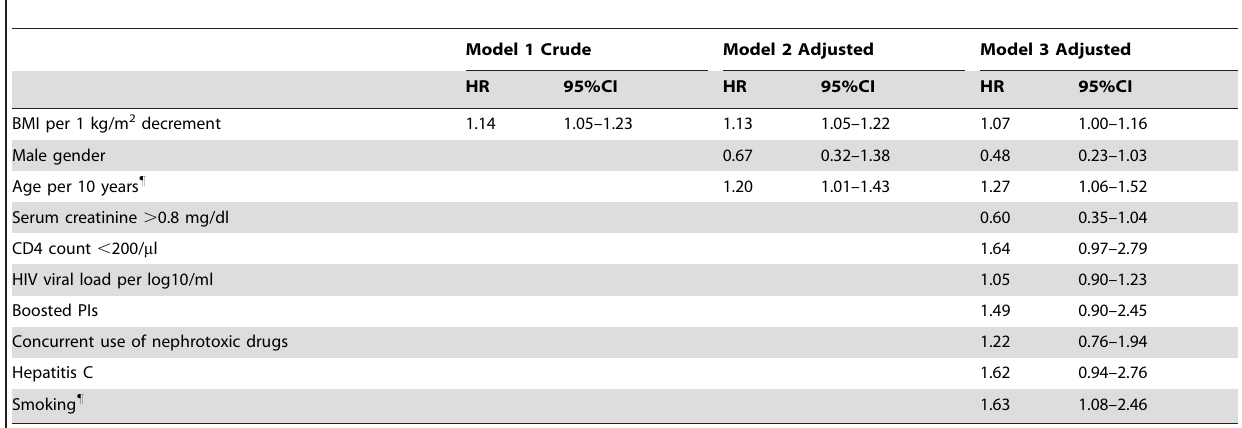
Table 4. Multivariate analysis to estimate the impact of BMI decrement on TDF-associated renal